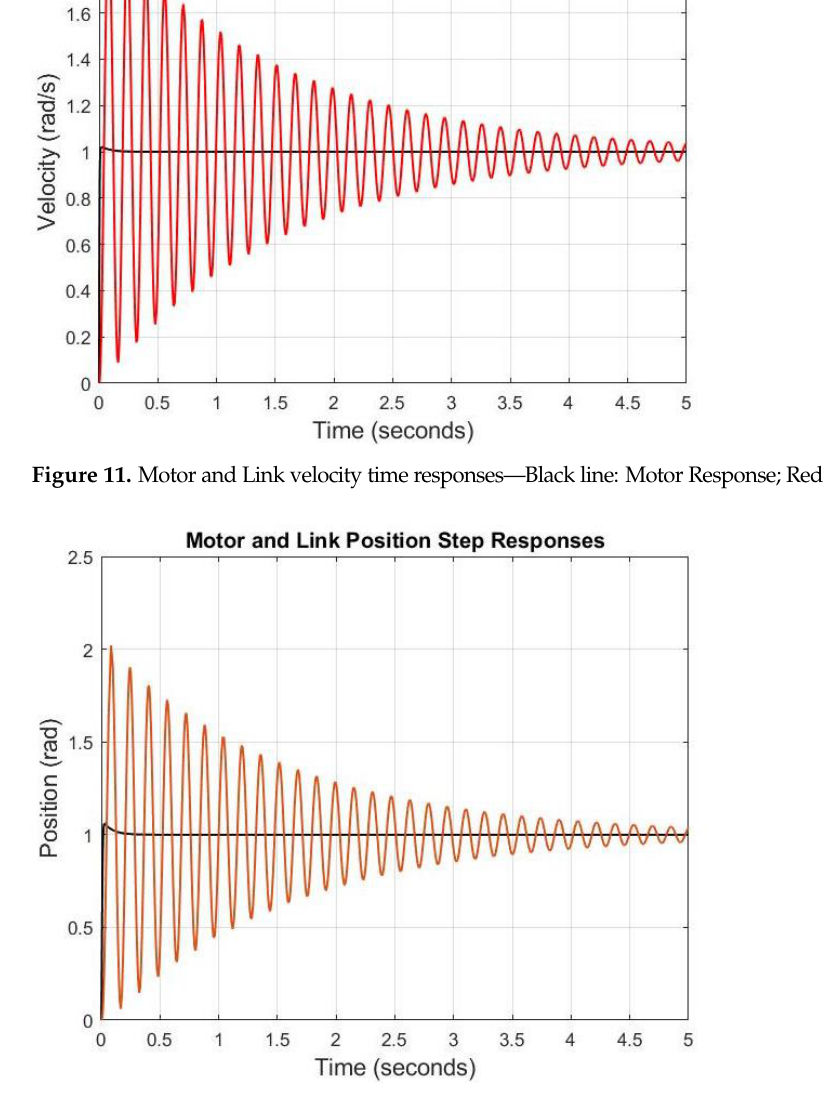
Figure 12. Motor and Link velocity time responses with variation in the link inertia—Black line: Motor Response; Red line: Link